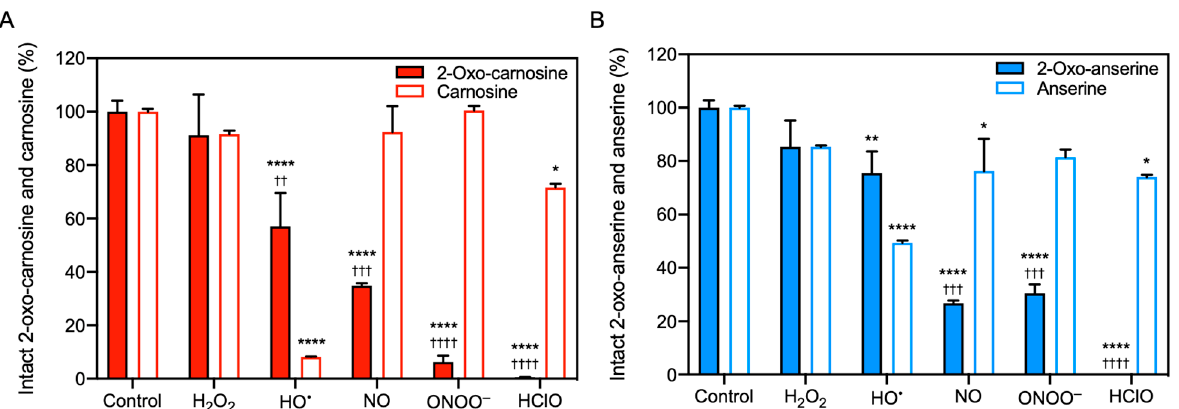
Figure 2. Reactivity of 2-oxo-IDPs and IDPs to radicals. 2-oxo-IDPs and IDPs were incubated in sodium phosphate buffer in the presence or absence of radicals: hydrogen peroxide (H 2 O 2 ), and hydroxyl radical (HO • ) generated by the H 2 O 2 /CuSO 4 system, nitric oxide (NO) released from 1-hydroxy-2-oxo-3-( N -methyl-3-aminopropyl)-3-methyl-1-triazene, peroxynitrite (ONOO − ), and hypochlorous acid (HClO) at 37 ◦ C for 30 min. The intact dipeptides ( A ), 2-oxo-carnosine and carnosine; ( B ), 2-oxo-anserine and anserine) in the reaction mixture were detected by high performance liquid chromatography with online electrospray ionization-tandem mass spectrometry (HPLC-ESI-MS/MS) analysis. Data are presented as means ± SEM ( n > 3). * p < 0.05, ** p < 0.01, **** p < 0.0001 versus the respective control; †† p < 0.01, ††† p < 0.001, †††† p < 0.0001 versus the corresponding IDPs under the same condition, compared using two-way analysis of variance with Tukey’s multiple comparison